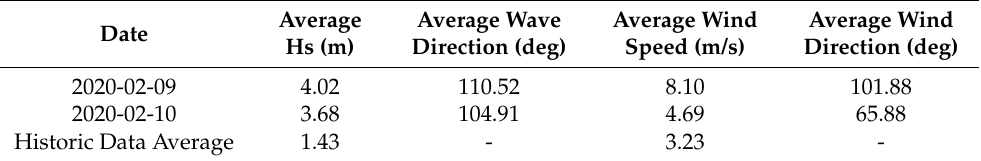
Table 2. Wave and wind data for an East Coast Lows (ECL) event compared to the historic average from the 35.7031 ◦ S, 150.3439 ◦ E Waverider Buoy and the Moruya Airport weather station.